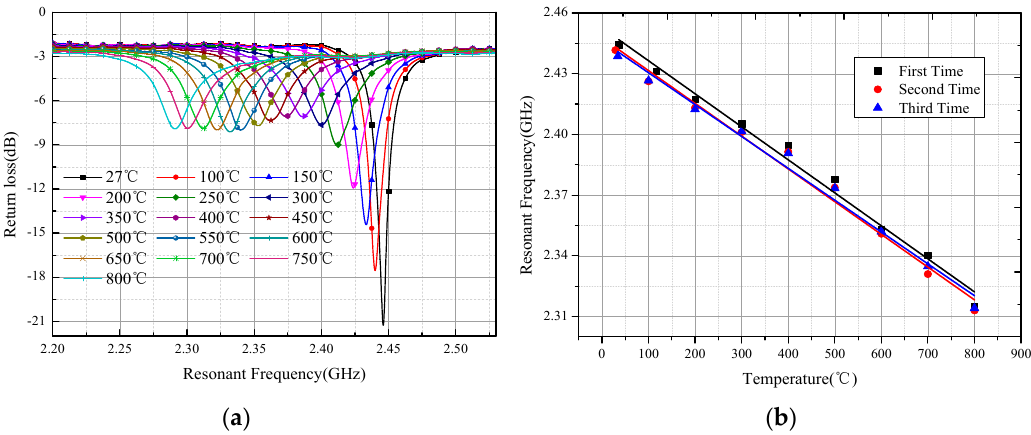
Figure 12. ( a ) Measured return loss curve versus frequency; ( b ) Extracted frequency versus temperature.